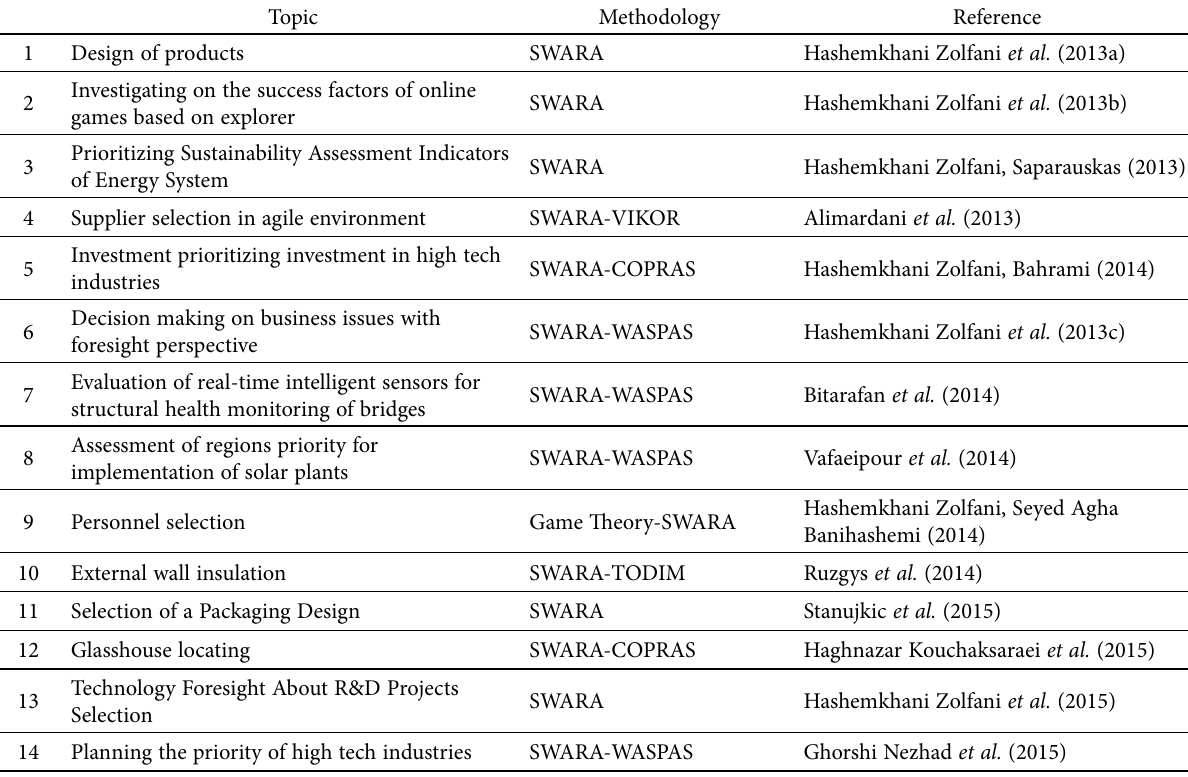
Table 3. Methodological development of SWARA